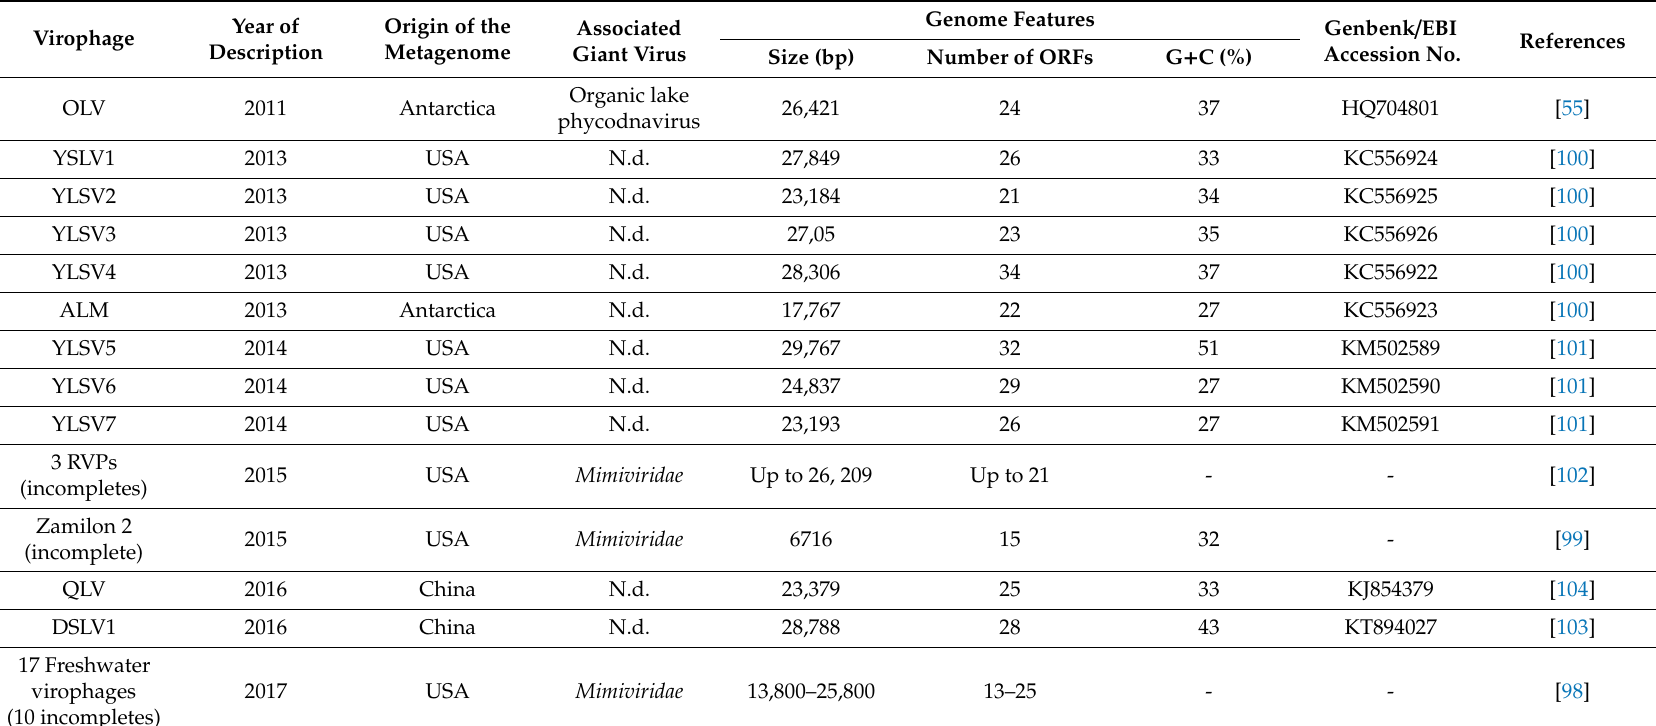
Table 2. Virophages discovered by metagenomics to date and their main